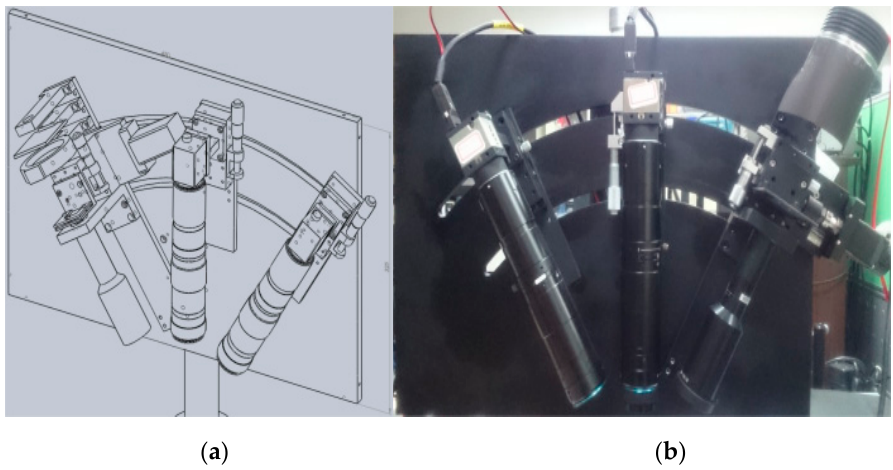
Figure 10. Developed system: ( a ) SolidWorks design; ( b ) system hardware.